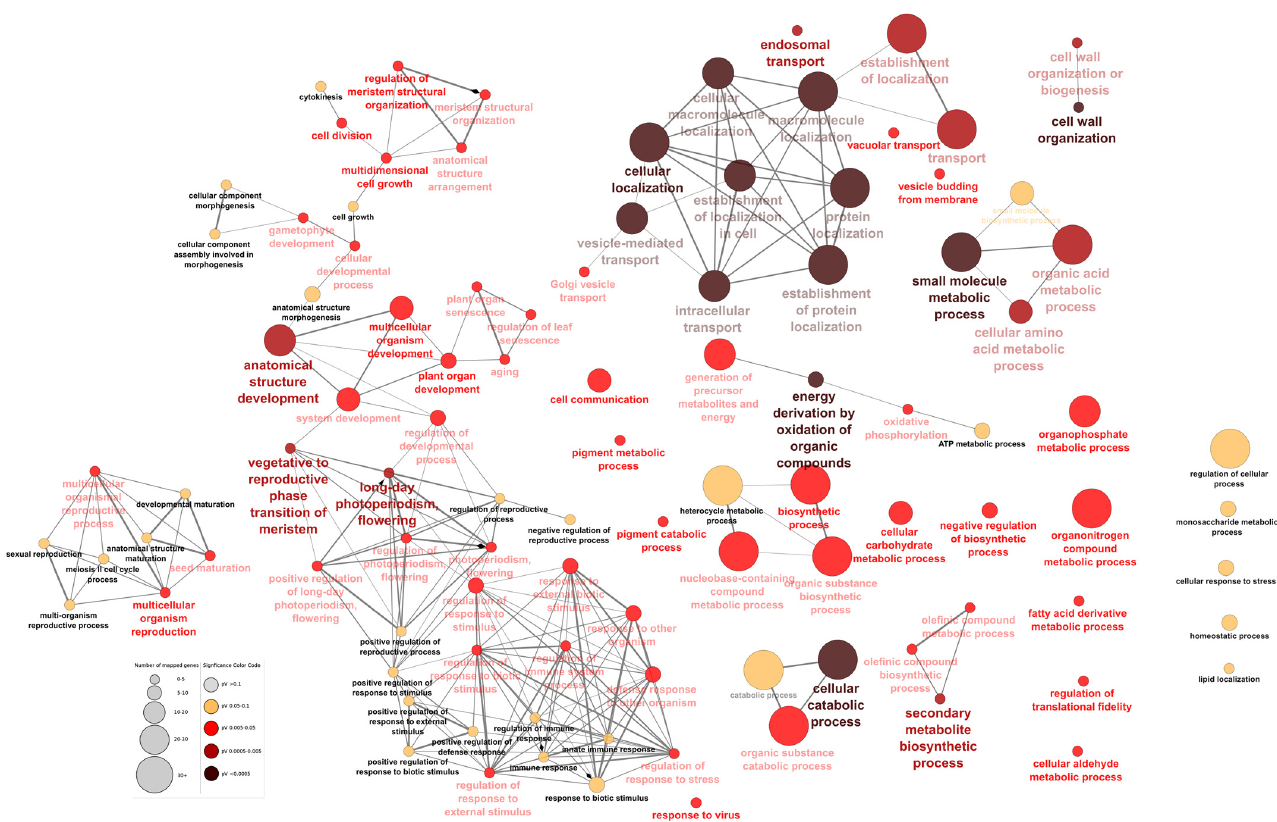
Figure 7. GO enrichment results for carrot genes possibly interacting with DcAHLs . Sizes of circles show the number of genes corresponding to GO terms, colors show significance of the enrichment, as shown in the significance legend box.